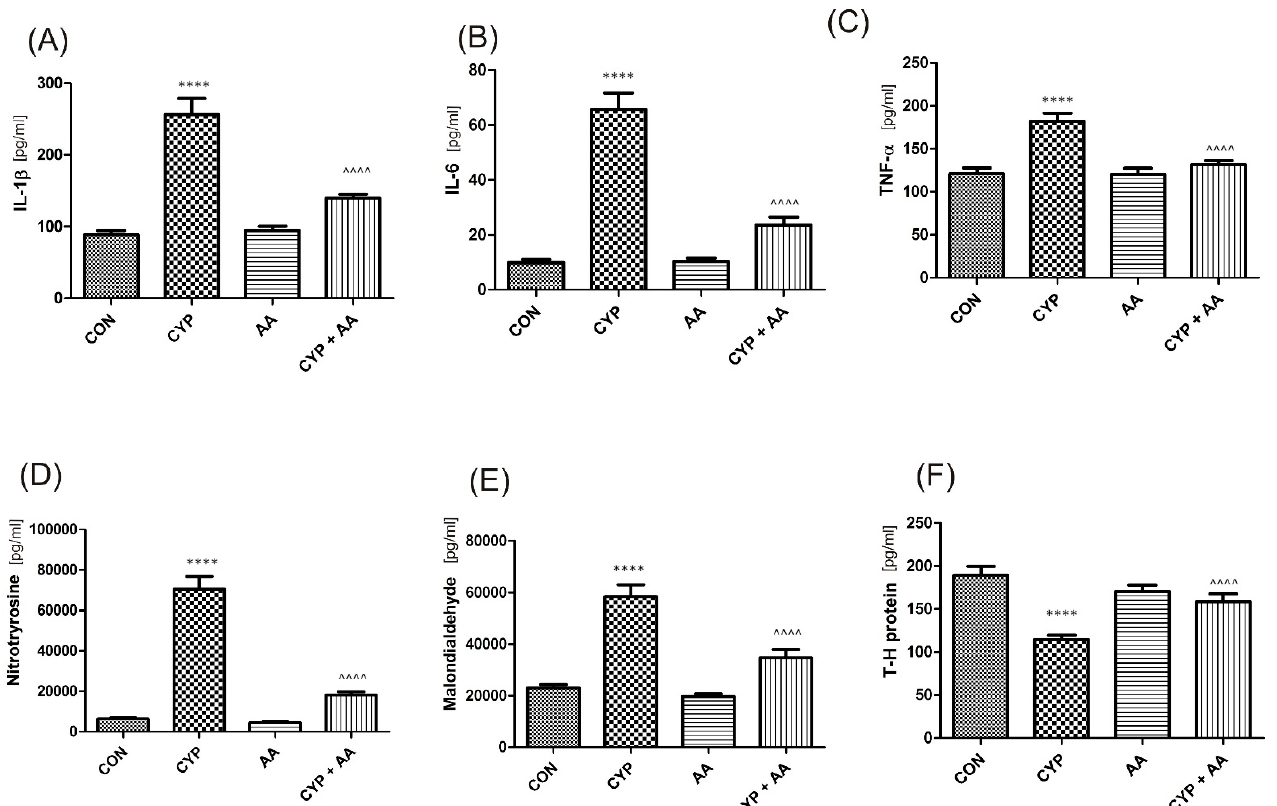
Figure 1. The effect of the two-week administration of asiatic acid (30 mg/kg/day for 14 days by oral gavage) on biomarkers in urothelium or in bladder detrusor muscle: ( A ) interleukin 1- β (IL-1 β ), ( B ) interleukin 6 (IL-6), ( C ) tumor necrosis factor alpha (TNF- α ), ( D ) 3-nitrotyrosine (NIT), ( E ) malondialdehyde (MAL), and ( F ) Tamm–Horsfall protein (T–H protein) in animals that were administered with a single injection of cyclophosphamide (CYP, 200 mg/kg, intraperitoneally). All results are presented as the mean ± SEM (n = 15 rats per group). The obtained data were assessed by the one-way ANOVA followed by Tukey’s post hoc test. * when significantly different from the control group. ^ when significantly different from the CYP group. **** or ^^^^ p < 0.0001. One-way ANOVA: for IL-1 β F(3.56) = 41, p < 0.0001, for IL-6 F(3.56) = 59, p < 0.0001, for TNF- α F(3.56) = 17, p < 0.0001, for NIT F(3.56) = 91, p < 0.0001, for MAL F(3.56) = 36, p < 0.0001, and for T–H protein F(3.56) = 15, p < 0.0001. AA: asiatic acid; CON: control; CYP: cyclophosphamide.